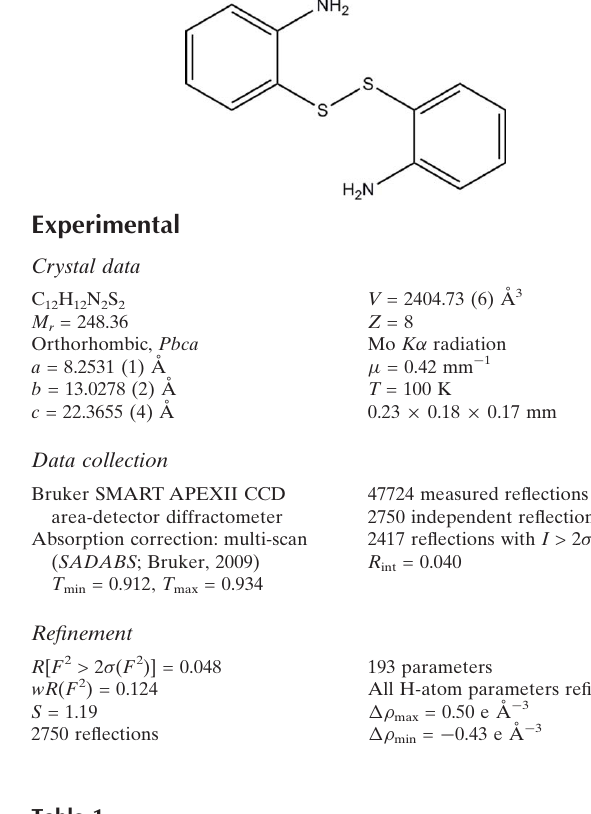
Hydrogen-bond geometry (A˚ , (cid:5) ). Cg 1 and Cg 2 are the centroids of the C7–C12 and C1–C16 phenyl rings, respectively. D —H (cid:2)(cid:2)(cid:2) A D